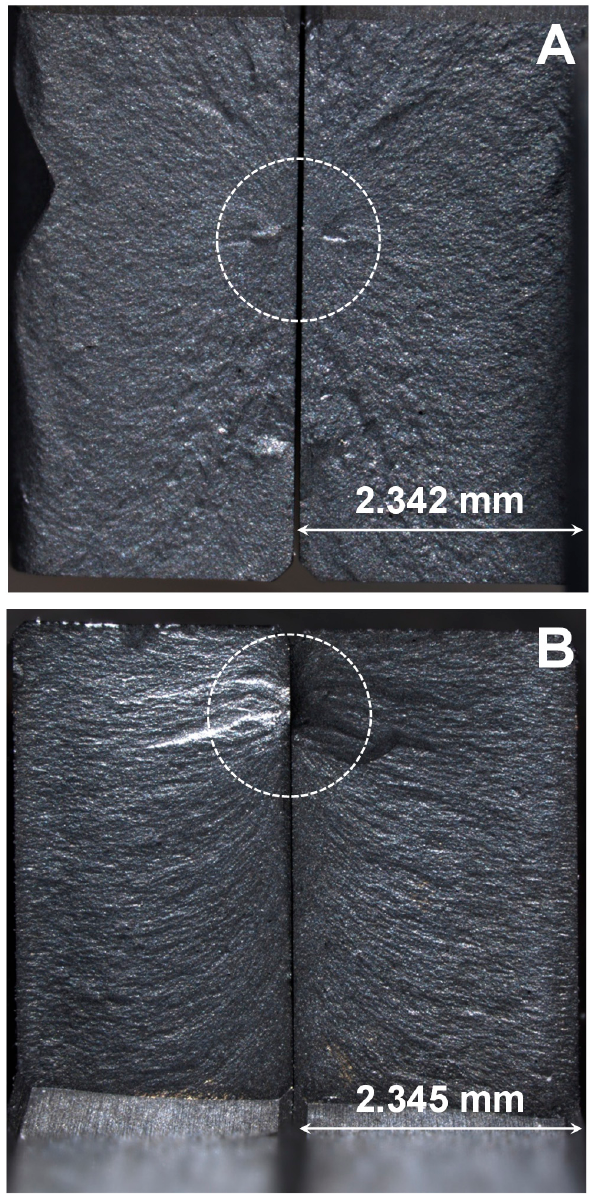
Figure 9. Optical micrographs of fracture surfaces of sample #2 failed at RT ( A ) and sample #3 failed at 800 °C ( B ). Table 4. Young’s moduli, hysteresis loop areas and creep strain shift parameters characterizing stress–strain deformation behavior of LaCoO 3 sample #3.